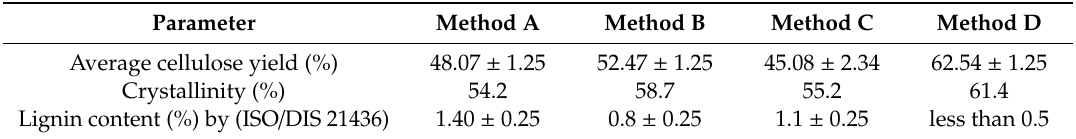
Table 1. The quality and yield of cellulose.